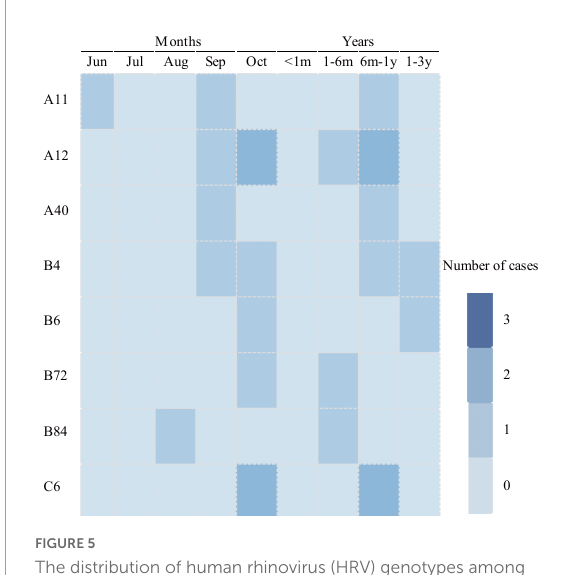
FIGURE5 The distribution of human rhinovirus (HRV) genotypes among patients of different ages.